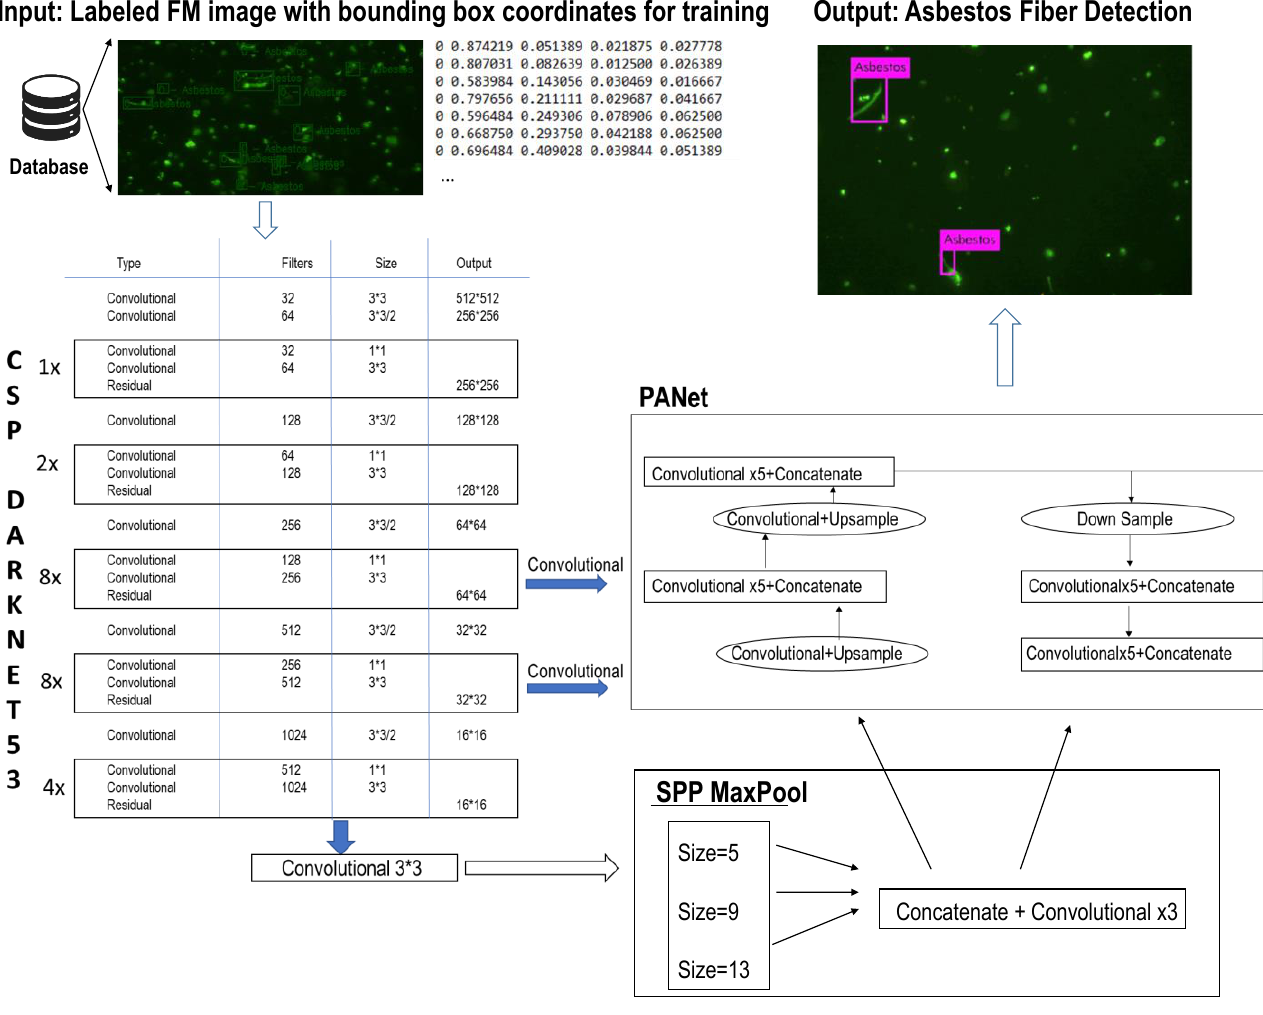
Figure 1. Flowchart and network architecture of YOLOv4 to detect asbestos.